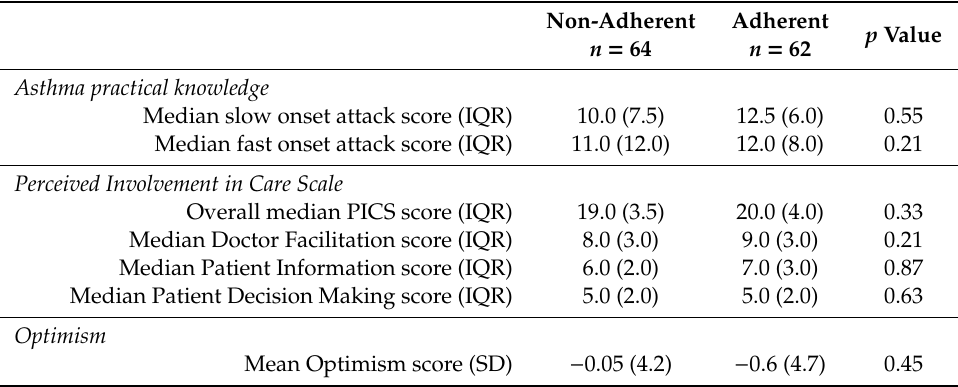
Table 5. Median scores for asthma practical knowledge and perceived involvement in care scales, and mean optimism for adherent and non-adherent